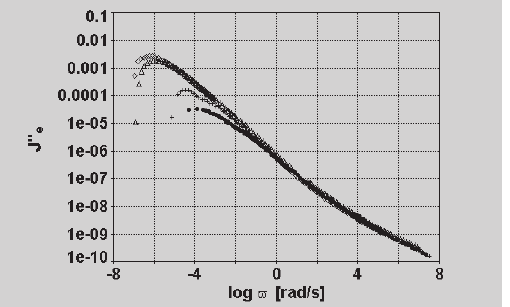
Figure 6 (left): Modified loss compliance (T r = 0°C: • Base, + 4% EVA, (cid:3)(cid:3) 4% SBS l, ◊ 4% SBSr). Figure 7: Relative modified loss compliance (T r = 0°C: +•+